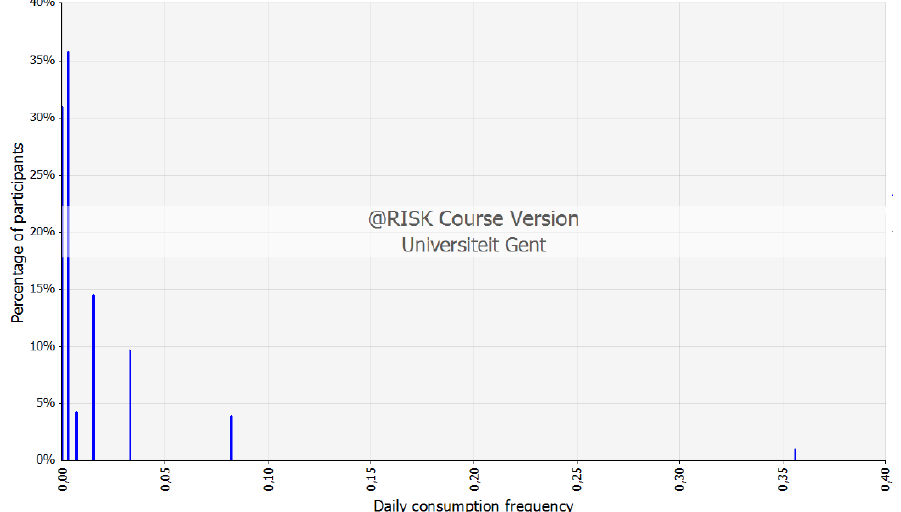
Figure 4. Discrete distribution on frequency of consumption of Yesso scallop (based on the data provided in Table S7 generated via @Risk software).